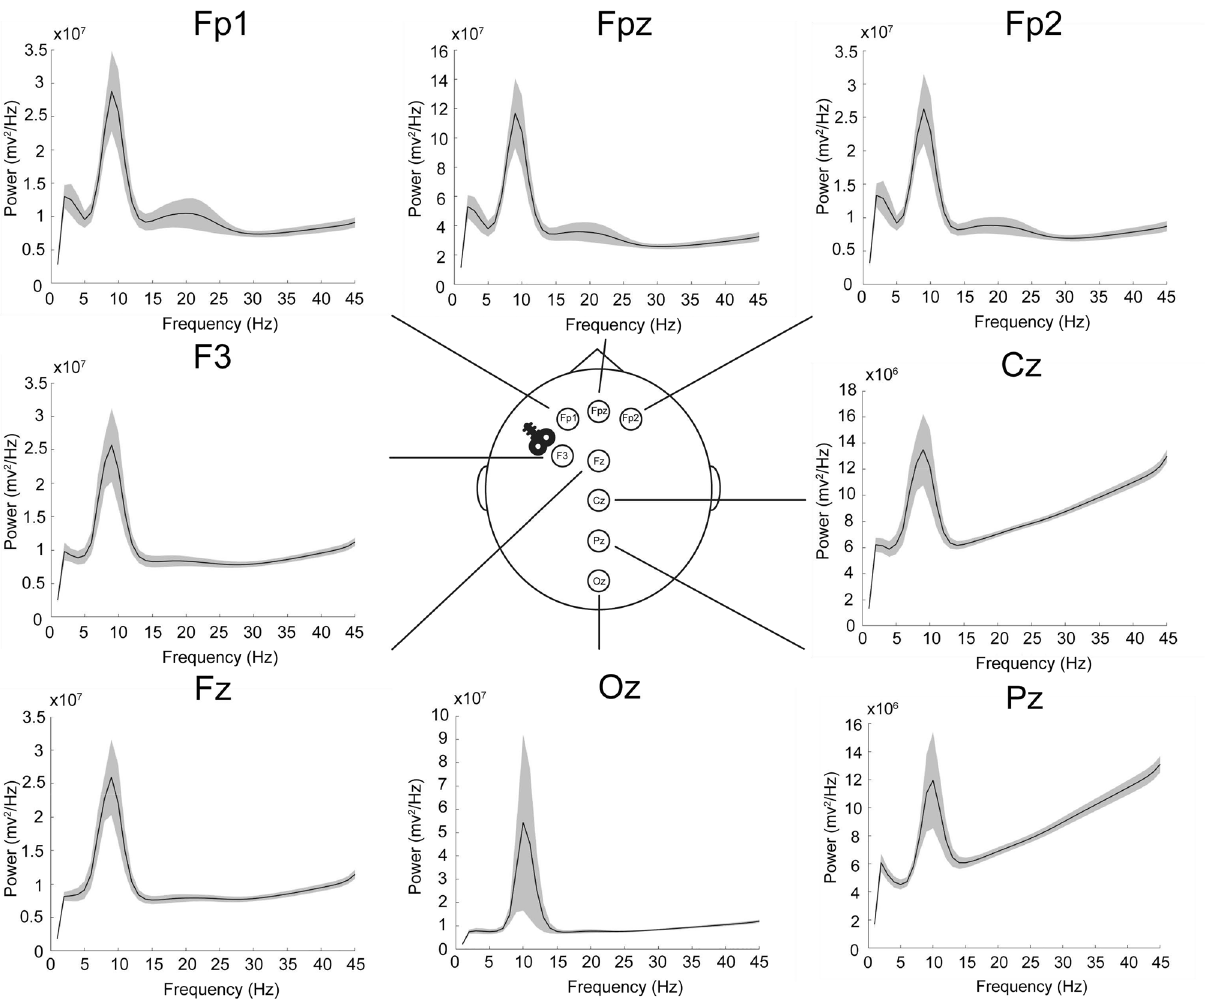
Figure 3. Power spectral density plots averaged across patients and EEG recording sessions for each electrode. Mean (solid line) and one standard error from the mean (transparent volumes)